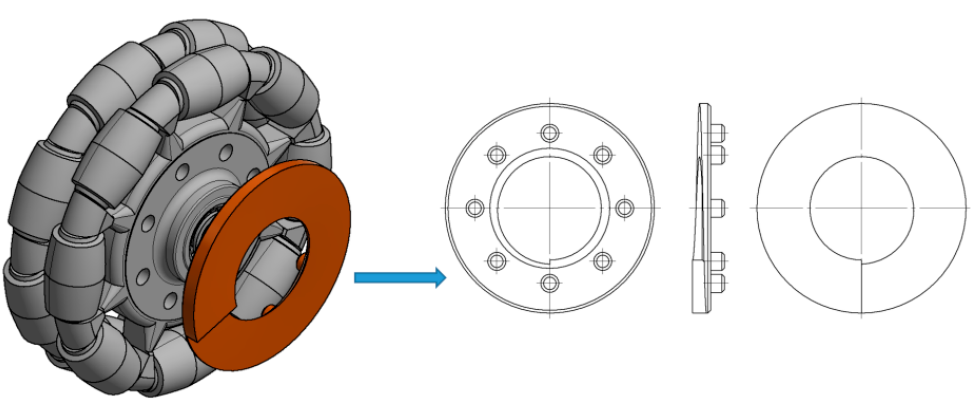
Figure 6. Position of the measuring instrumentation. ( A ) optical sensors, ( B ) optical sensors, ( C ) LVDT displacement sen- sor.